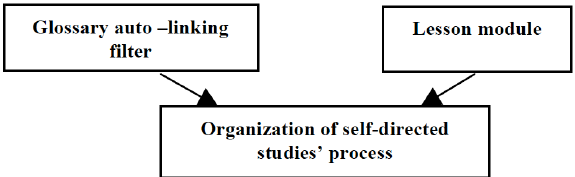
Figure 1. Role of students in the e-learning